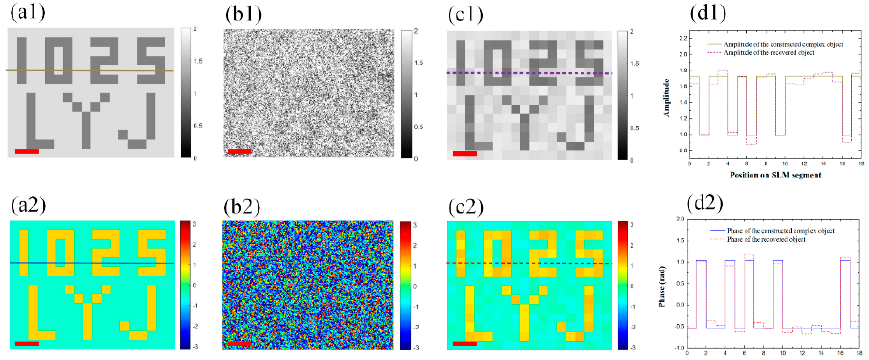
Figure 4. Complex amplitude object constructed by the SLM using two phase masks (1) SLM ( , ) O ξη and (2) ( , ) O ξη . ( a ) amplitude=1 and phase π /3 = for the characters part, ( b ) amplitude= 3 and SLM phase=- π /6 for the background part.